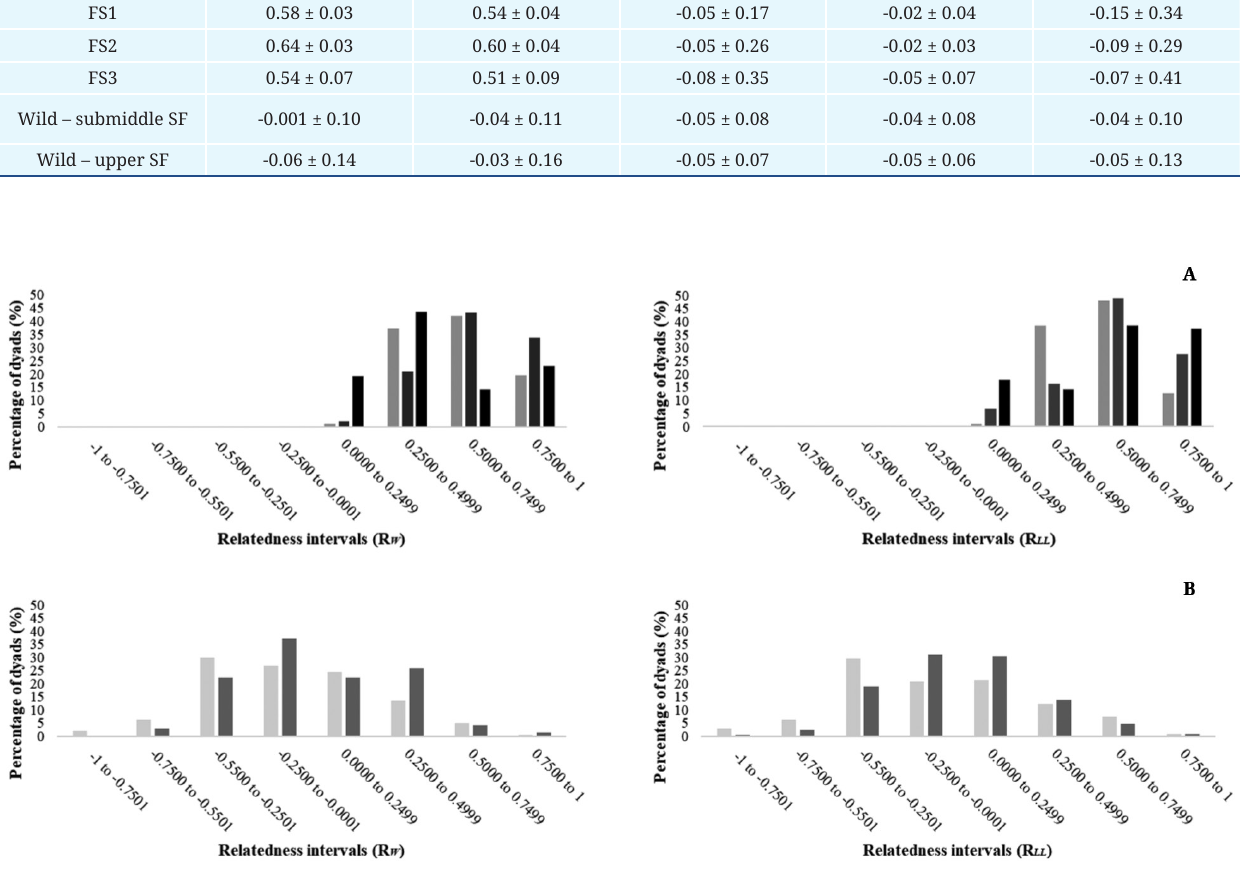
) and Lynch & Li (R ) calculated for A. the three full-sib families (■ FS1, ■ FS2 and ■ FS3) and W LL